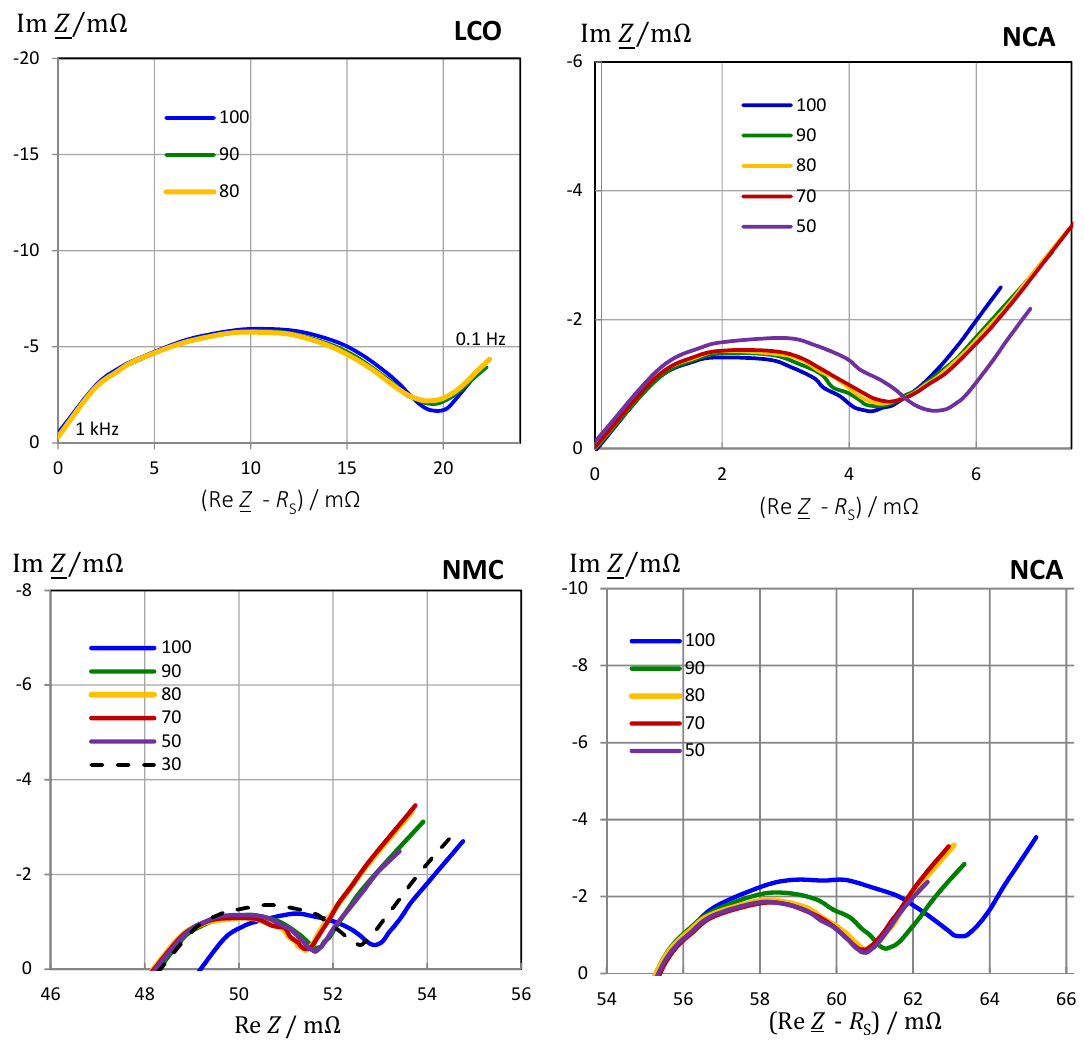
Figure 8. Impedance spectra of different lithium-ion chemistries at rest in defined charge states. NMC as measured to show the influence of SOC on electrolyte resistance. LCO and NCA are shifted on the real axis to the electrolyte resistance of SOC = 1. Frequency range 0.1 Hz to 1 kHz.